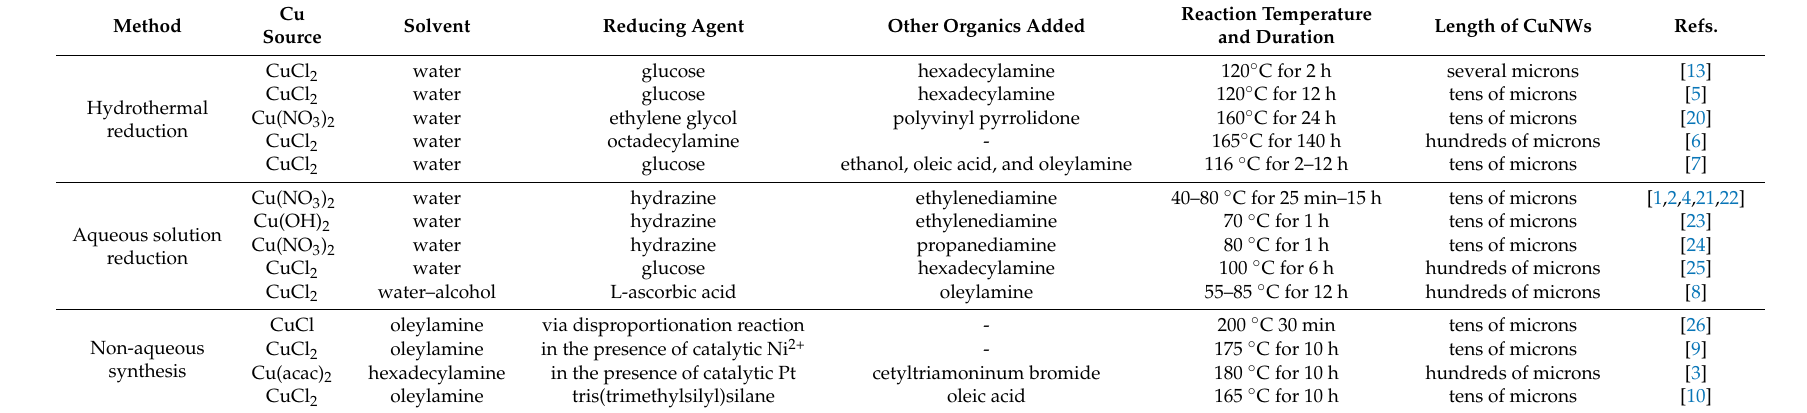
Table 1. Methods for synthesis of long Cu nanowires (CuNWs) in the presence of organic